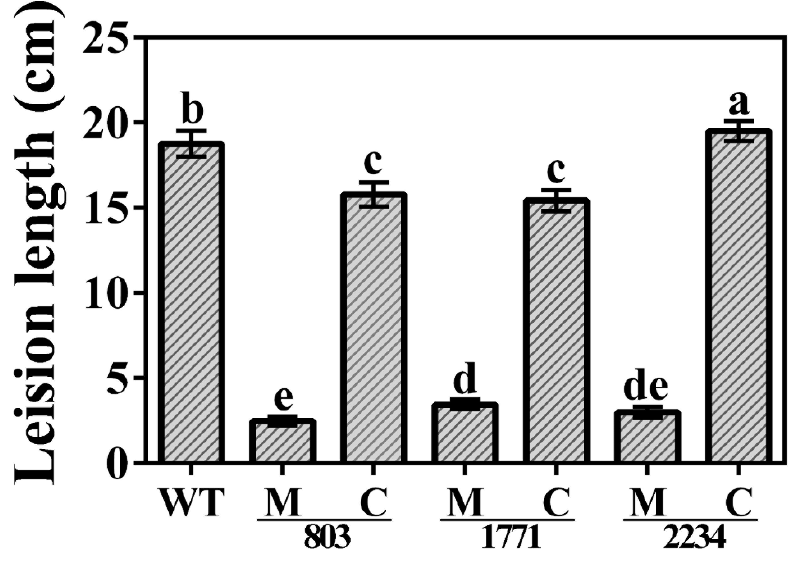
Figure 8. Lesions length on leaves of rice at 14 days after clipping inoculation of the three knockout mutants and corresponding complemented strains of Xanthomonas oryzae pv. oryzae strain C2. WT: Wild type; H 2 O: Negative control; M: Knockout mutant; C: Complemented strains. Lesion length (cm) was presented as means ± standard errors ( n = 3). Columns with different letters (a–e) are significantly different according to LSD test ( p = 0.05).